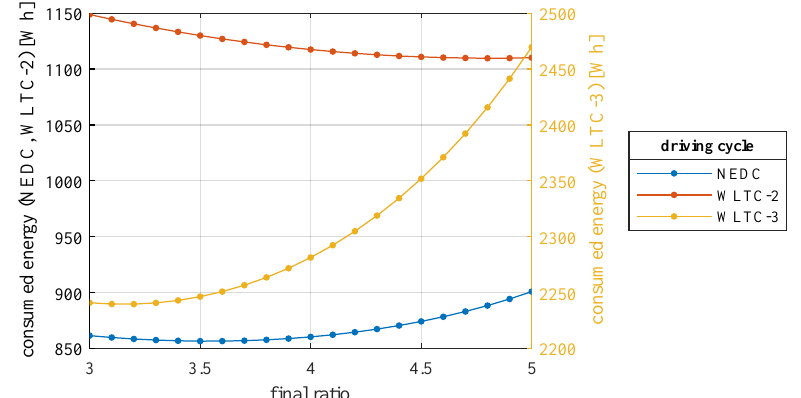
Figure 7. Final ratio influence carried out in the model simulations. The state of charge is inversely related to the energy consumed. With a traveled distance of 27 km and a maximum speed of 127 km/h, the WLTC-3 cycle depletes the battery faster than the NEDC or WLTC-2 cycles. Starting with a full battery, SOC = 91% is attained after the WLTC-3 cycle. In contrast, SOC = 95.99% and SOC = 96.36% for NEDC and WLTC-2 cycles, respectively.